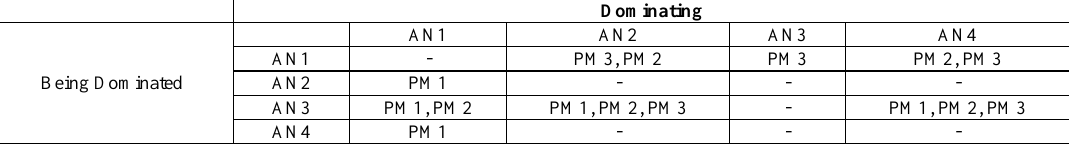
Table 26. Dominating interaction matrix - ranking of actions with reference to the